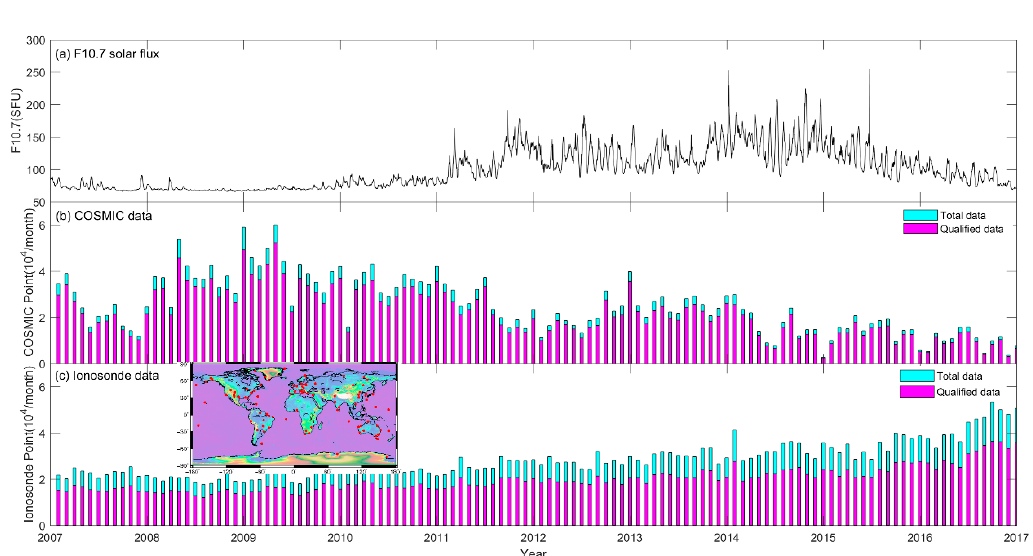
Figure 1. Daily averaged F10.7 and the numbers of COSMIC and ionosonde measurements per month during 2007–2016.